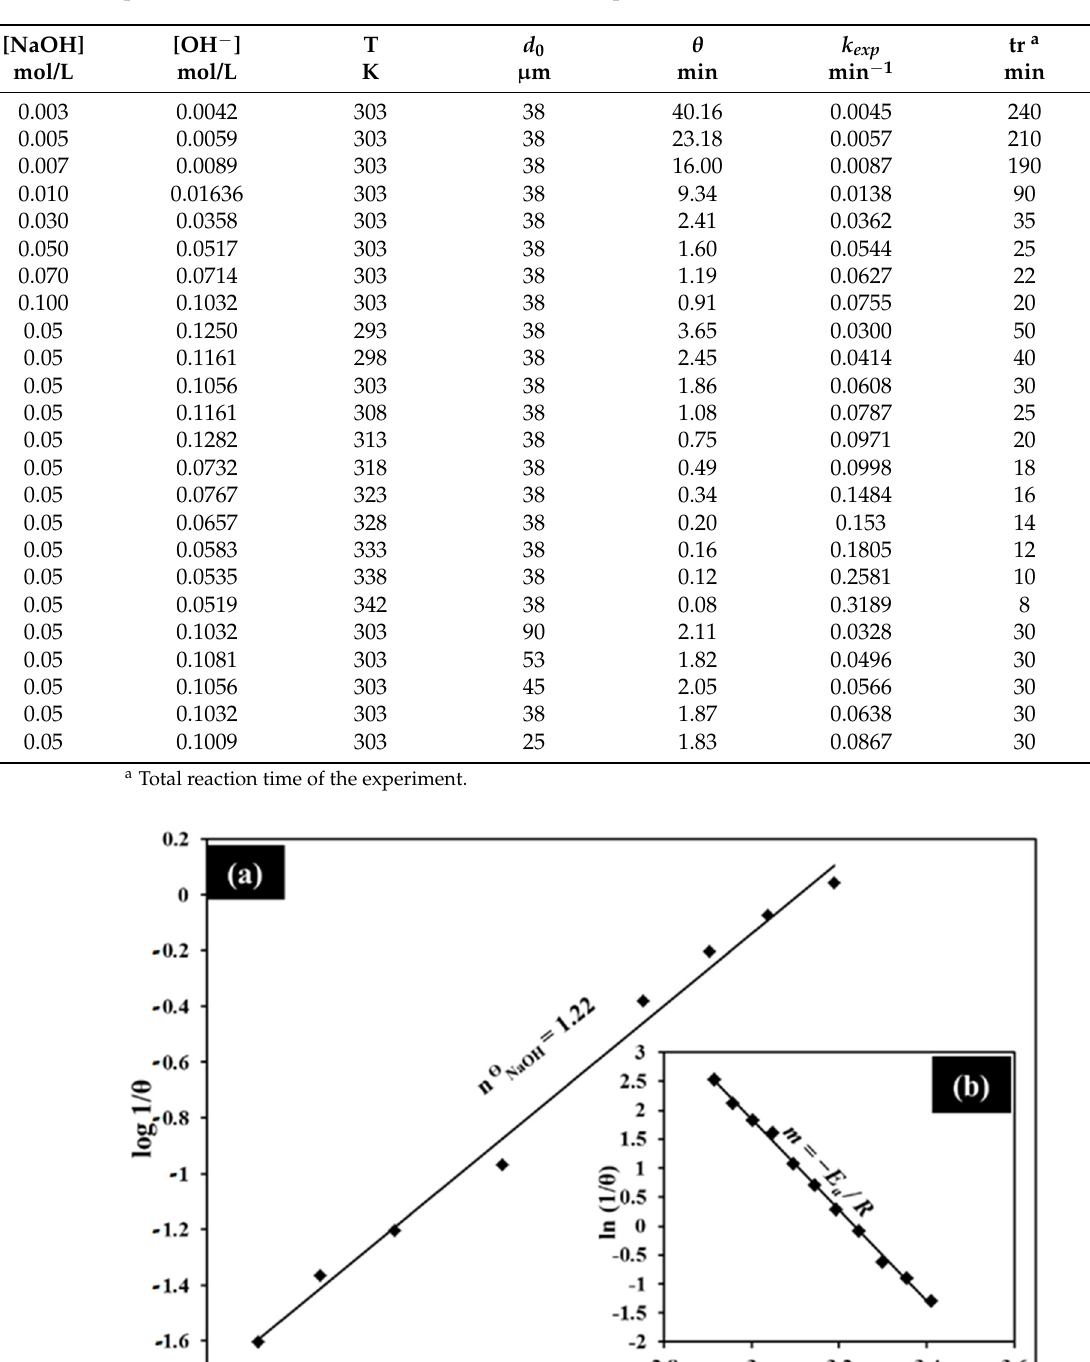
Table 5. Decomposition of ammonium-sodium jarosite with arsenic in NaOH media. Conversion